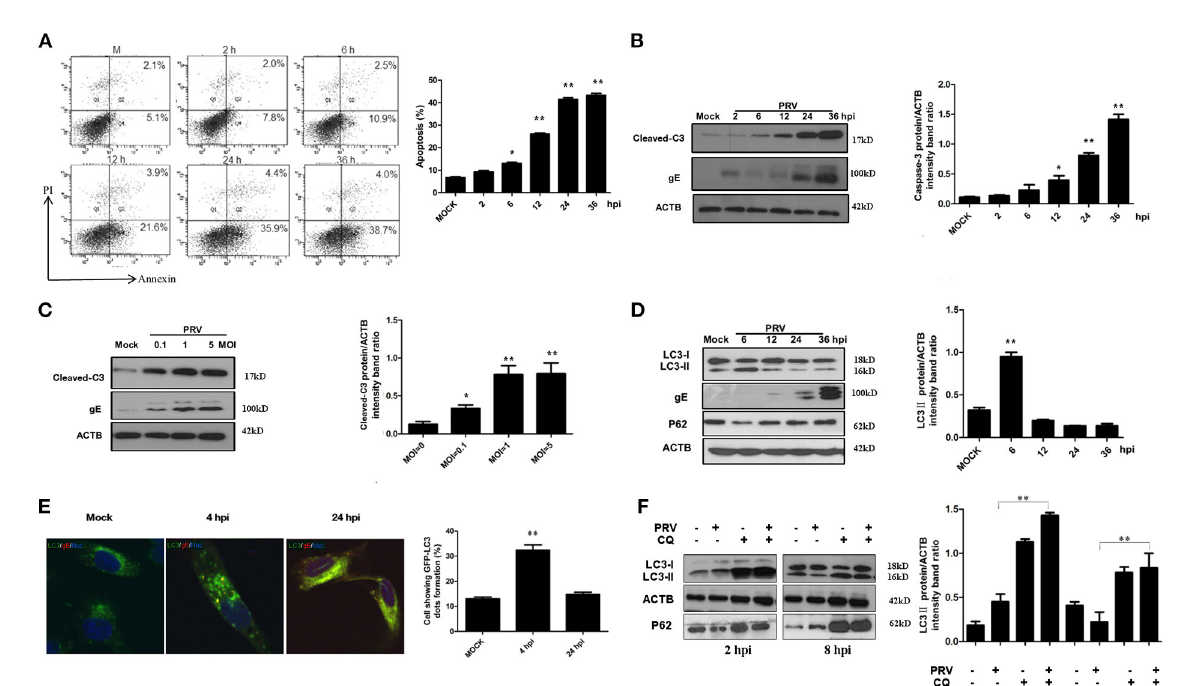
FIGURE1 PRV induces caspase-dependent apoptosis and autophagy in different stages of infection. (A) PK-15 cells were infected with PRV at the MOI of 1 at different times, and apoptotic cells were analyzed by flow cytometry. The percentage of apoptotic cells was represented as the histogram. (B) PK-15 cells infected with the PRV virus at the MOI of 1 and lysed at indicated time points, and the cell extracts were analyzed by Western blot. The ratios of intensity of cleaved caspase-3 to ACTB were calculated. (C) PK-15 cells were infected with PRV at different MOIs for 24h. Then the cells were harvested and analyzed by Western blot. The ratios of intensity of cleaved caspase-3 to ACTB were calculated. (D) The cells were infected with PRV at the MOI of 0.1. Cells were lysed at different time points and analyzed by Western blot. The ratio of the intensity of LC3-II to ACTB was calculated to represent the autophagic level. (E) PK-15 cells were infected with PRV following transfected with GFP-LC3 for 24h and then detected by confocal microscopy. The PRV gE protein was stained in red. The cells showing GFP-LC3 dot formation and cells expressing GFP were counted, and at least 50 cells were included in each group. The results were represented as the histogram. (F) PK-15 cells were pre-treated with CQ for 4h, followed by PRV infection at an MOI of 1. Cell samples were harvested at 2 and 8 hpi, and analyzed by Western blot. The ratio of the intensity of LC3-II to ACTB was calculated to represent the autophagic level. All the dates are representative of three independent experiments. The data represent the mean ± SD, and analyzed by two-way ANOVA, * P < 0.05; ** P <